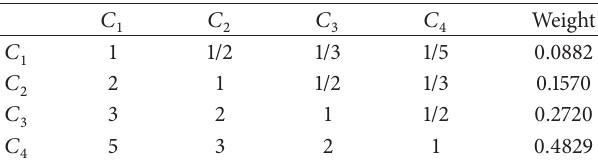
Table 7: Result of weight.